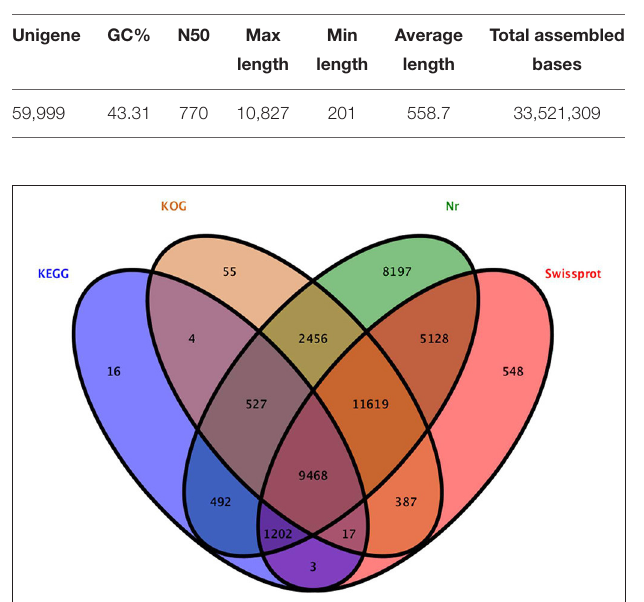
FIGURE 4 | Venn diagram of unigenes annotated to the four databases.